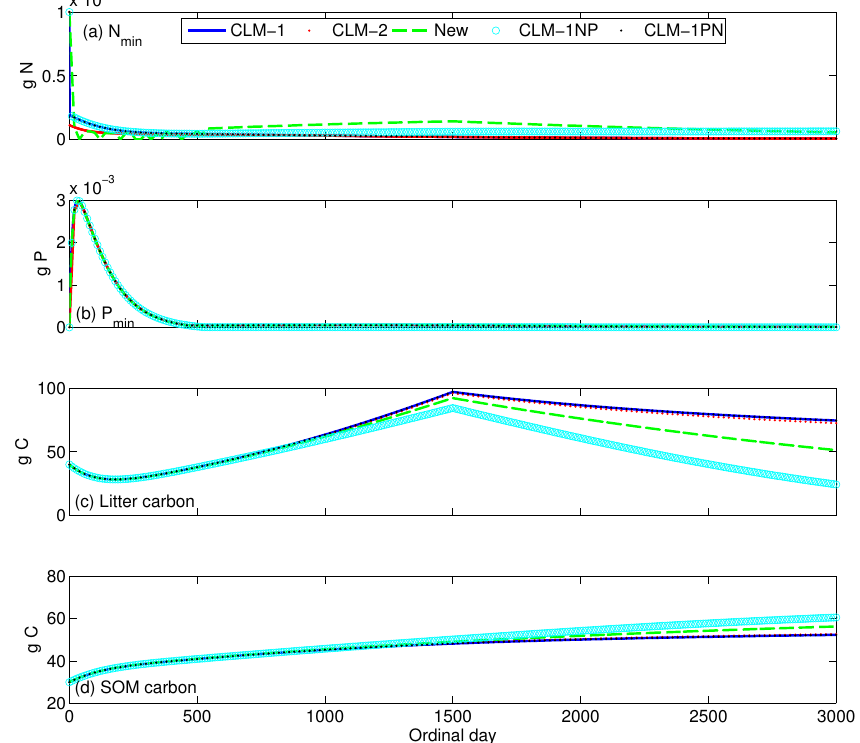
Figure 5. Simulated decomposition dynamics for Case 4 in Table 3. CLM-1NP performs nitrogen down-regulation before phosphorus down-regulation, whereas CLM-1PN reverses the order. Similarly to CLM-1 (Appendix C), both CLM-1NP and CLM-1PN assume the nutrient mobilizer and immobilizer are independent within a numerical time step. In all panels, CLM-1PN predictions overlap with CLM-1